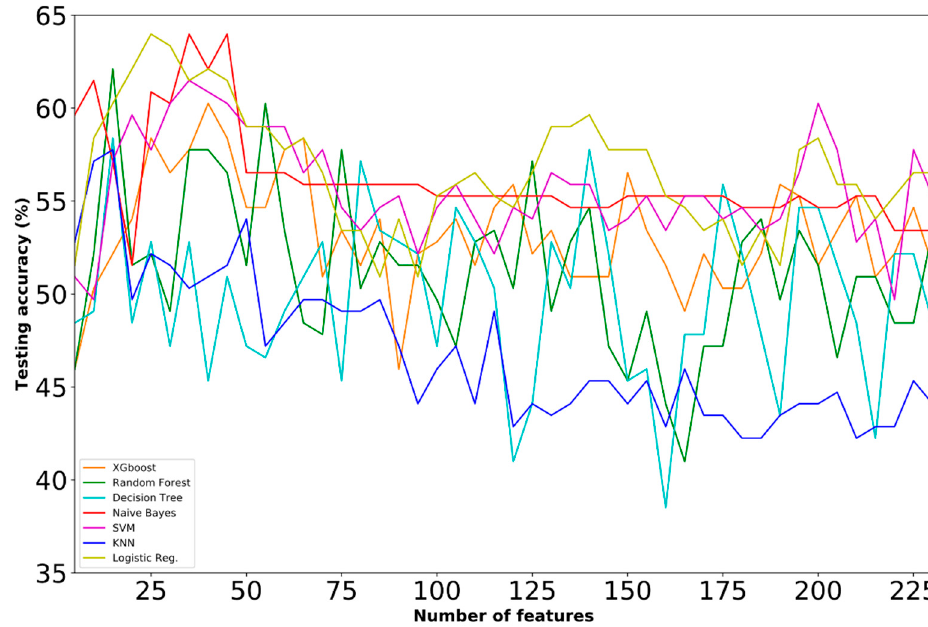
Figure 8. Learning curves with testing accuracy scores on dataset B for different ML models trained on feature subsets of increasing dimensionality. Table 5. Best testing accuracies achieved for each ML model along with the confusion matrix, the optimum number of features and the hyperparameters of the ML models employed. B1 and B2 denote classes 1 and 2 of dataset B,